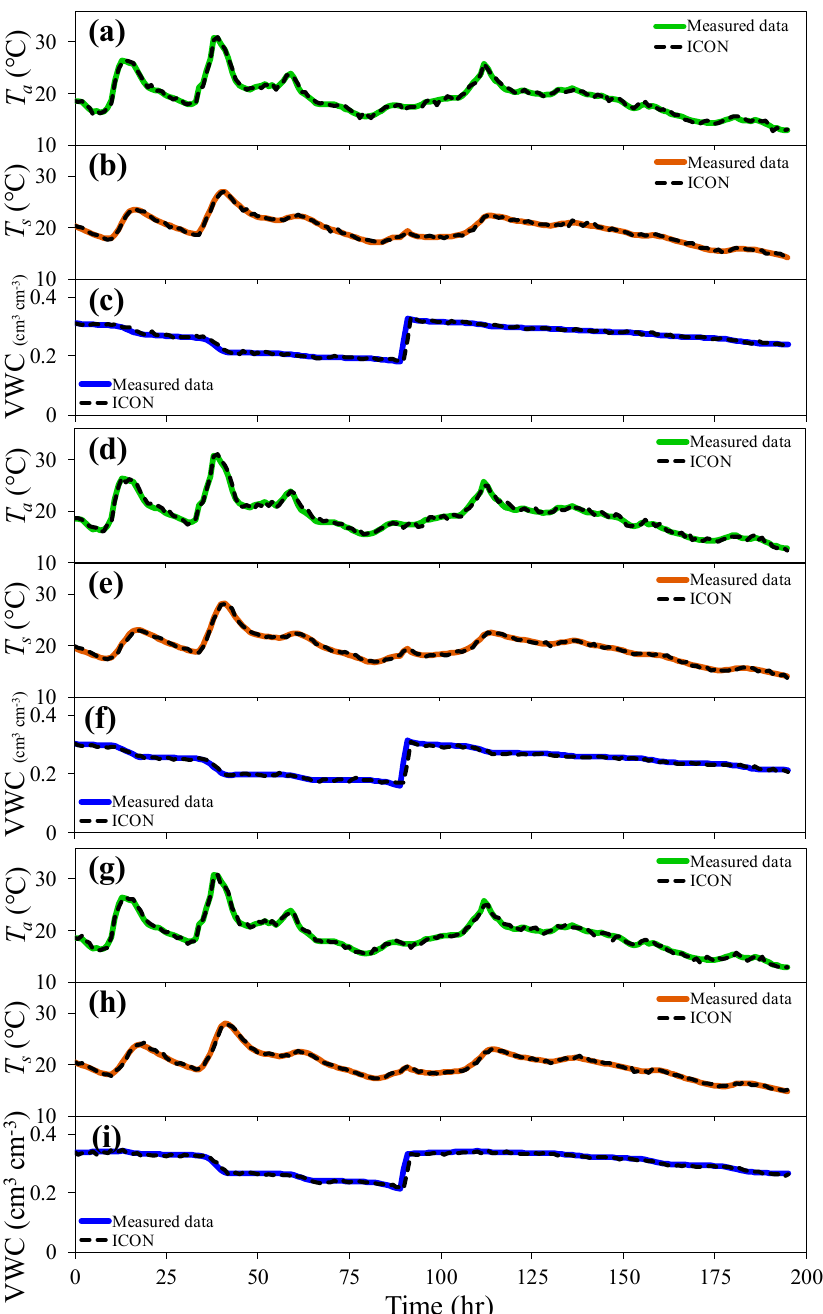
Figure 10. Simulation results of the ICON model in baskets ( a – c ) No. 12, ( d – f ) No. 13, and ( g – i ) No. 14 for ( a , d , g ) air temperature ( T a ), ( b , e , h ) soil temperature ( T s ), and ( c , f , i ) volumetric water content (VWC).